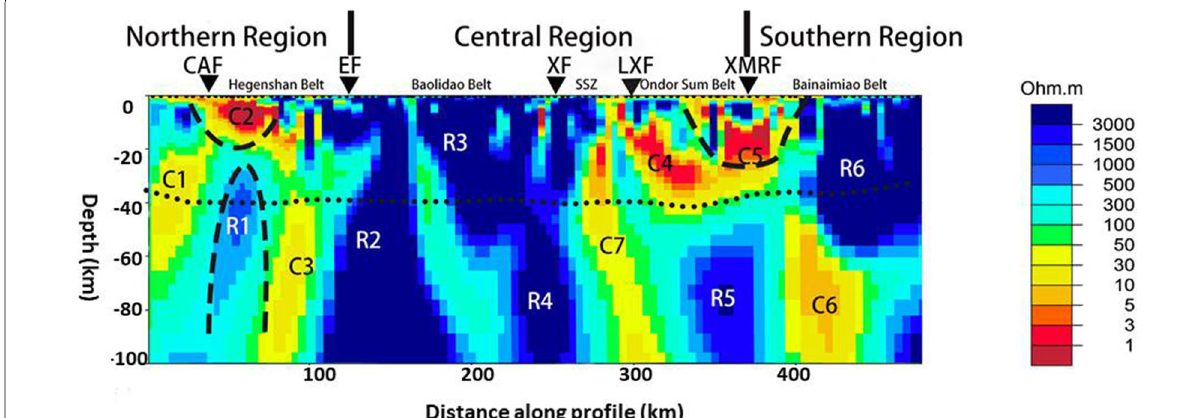
Fig. 7 Inversion results. The left side represents the north. Here, CAF indicates Chagan Obo Fault, EF indicates Erlian–Hegenshan Fault, XF indicates Xinlinhot Fault, SSZ indicates Solonker Suture Zone, LXF indicates Linxi Fault, and XMRF indicates Xar Moron River Fault. The dotted line around 40 km represents the Moho (Fu et al. 2021). C1 and C5 circled by dashed lines, represent the Meso-Cenozoic basins related to the Erlian Basin and the Songliao